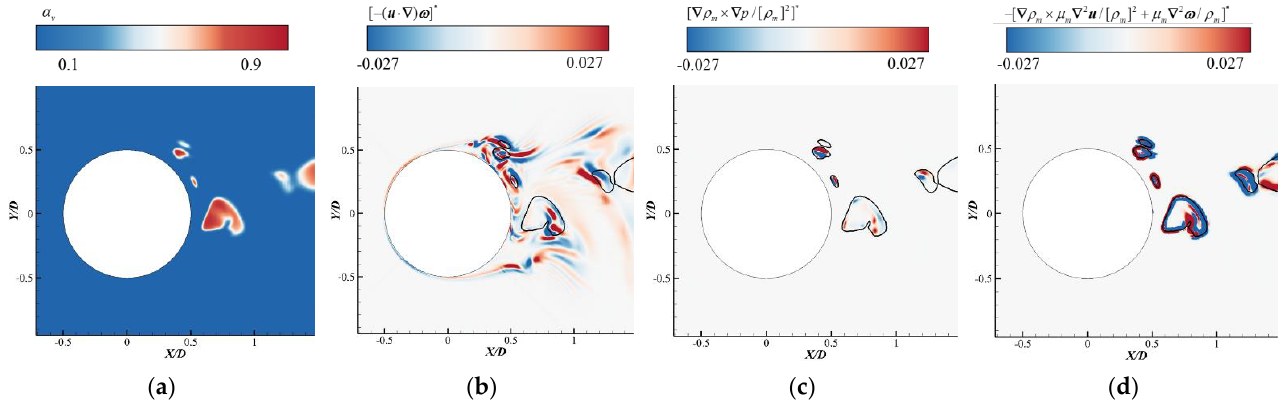
Figure 8. Distributions of the vapor phase volume fraction, the vortex expansion and contraction term distribution, the baroclinic moment term and the vortex viscosity dissipation term: ( a ) the vapor phase volume fraction; ( b ) the vortex expansion and contraction term; ( c ) the vortex baroclinic moment term; ( d ) the vortex viscous dissipation term.